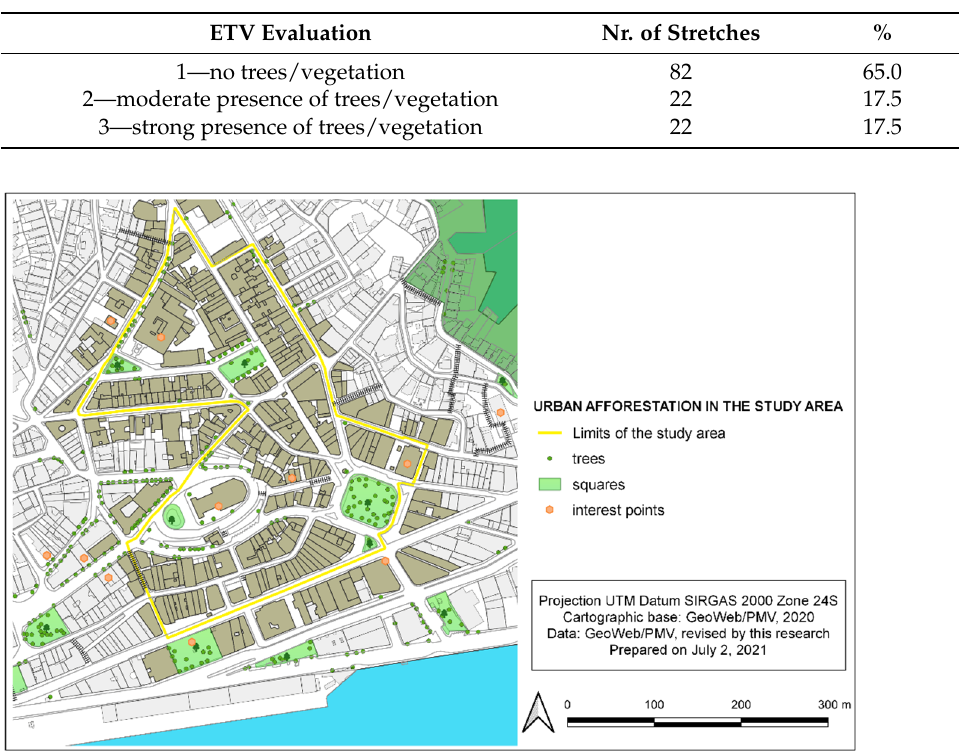
Table 9. Existence of urban furniture (EUF) .